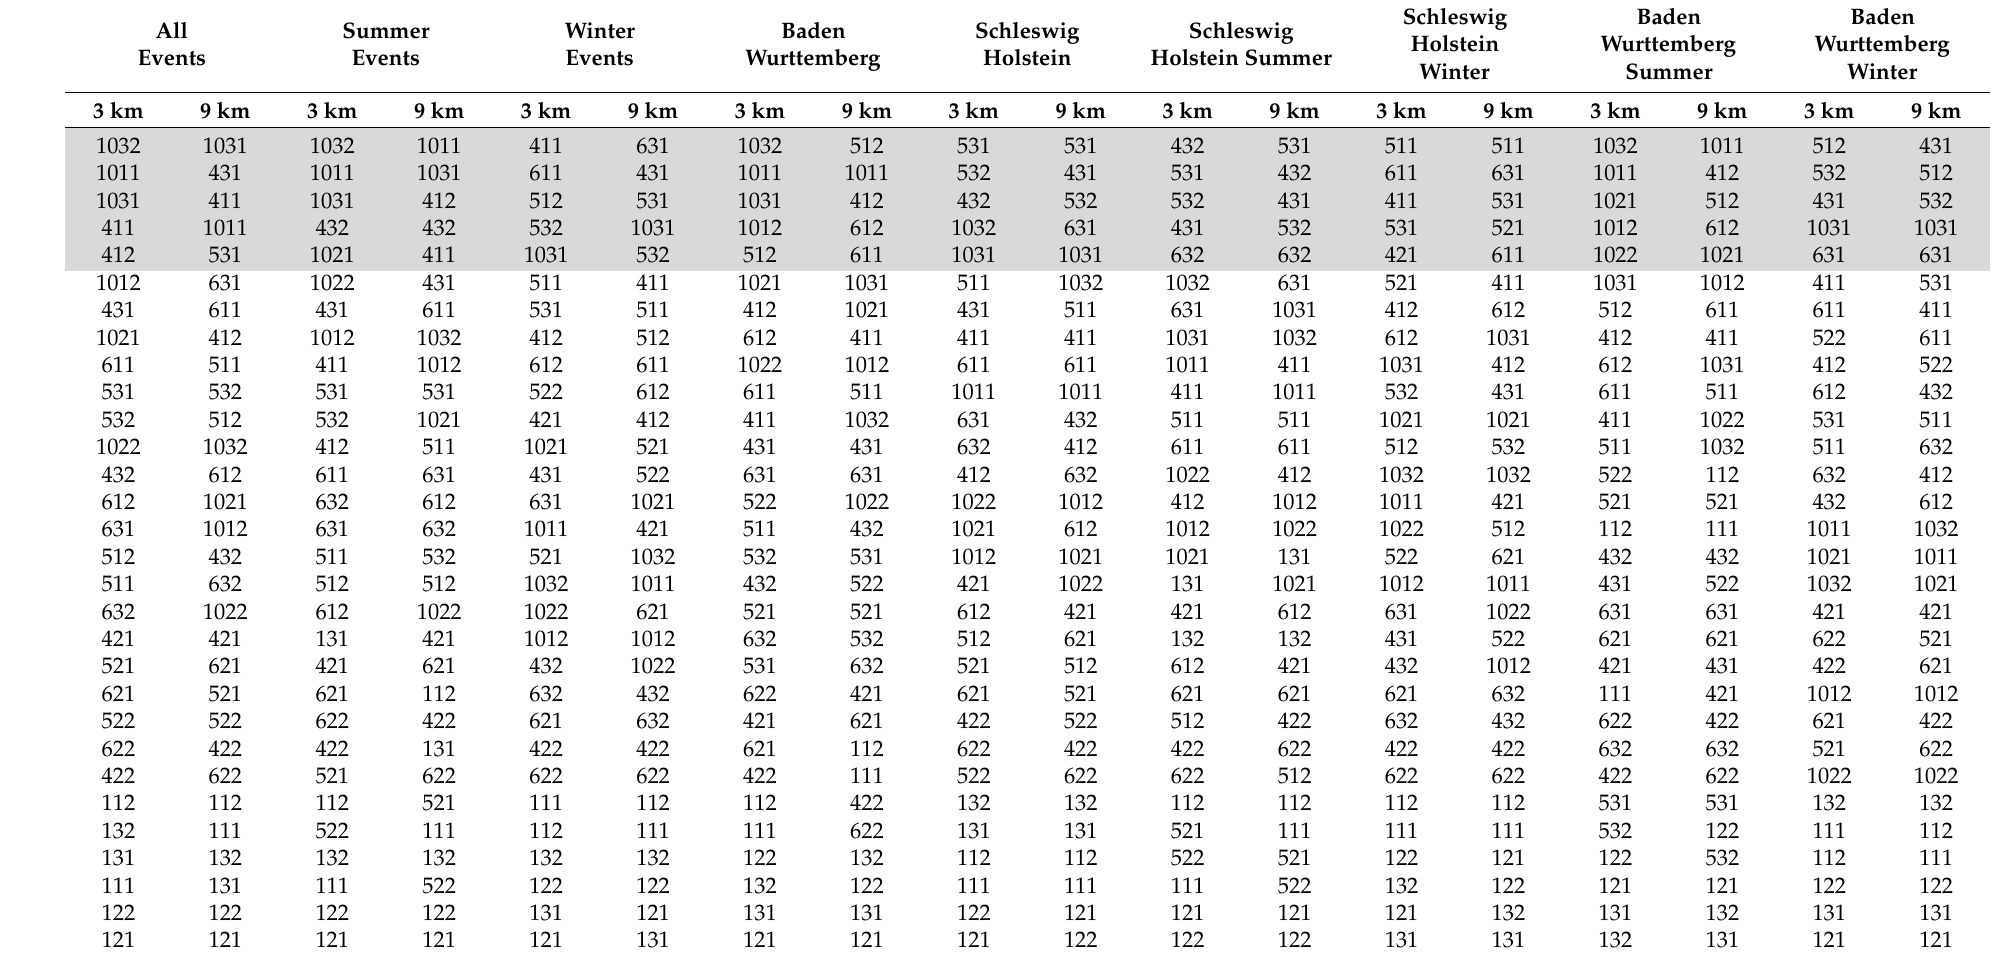
Table 6. TOPSIS scenario ranking. Top 5 performing scenarios for each episode and grid resolution are highlighted in